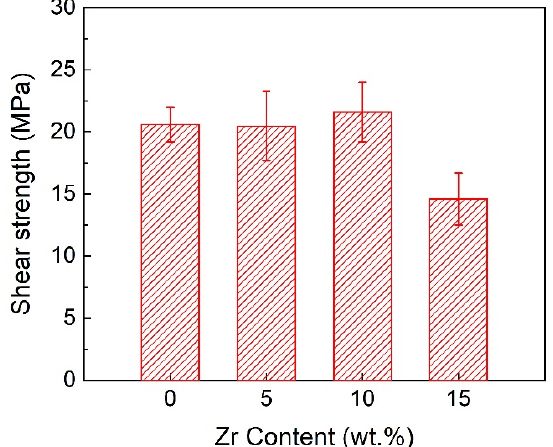
Figure 12. Effect of Zr content on joint shear strength.